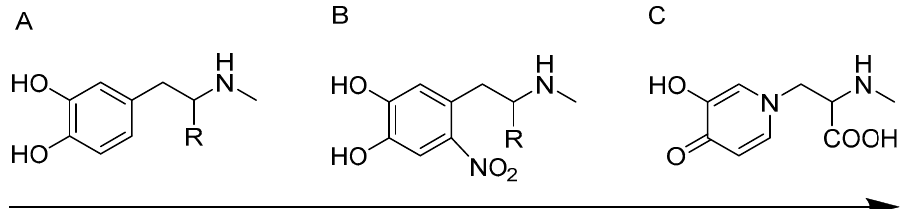
Figure 6. Catechol derivatives with increasing binding affinity to MNPs. ( A ) Catechol; ( B ) Nitrocatechol; ( C ) Mimosine. Reprinted from [140] with permission of ACS Publications.